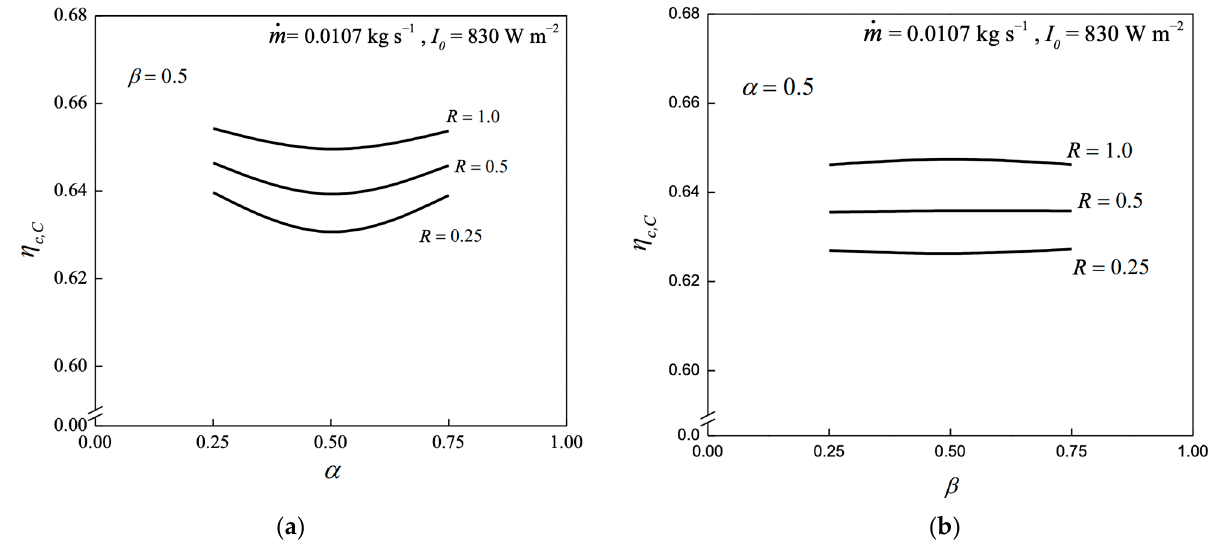
Figure 9. Effects of aspect ratios on collector thermal efficiencies: ( a ) Aspect ratio 𝛼 variations; ( b ) Aspect ratio 𝛽 variations.